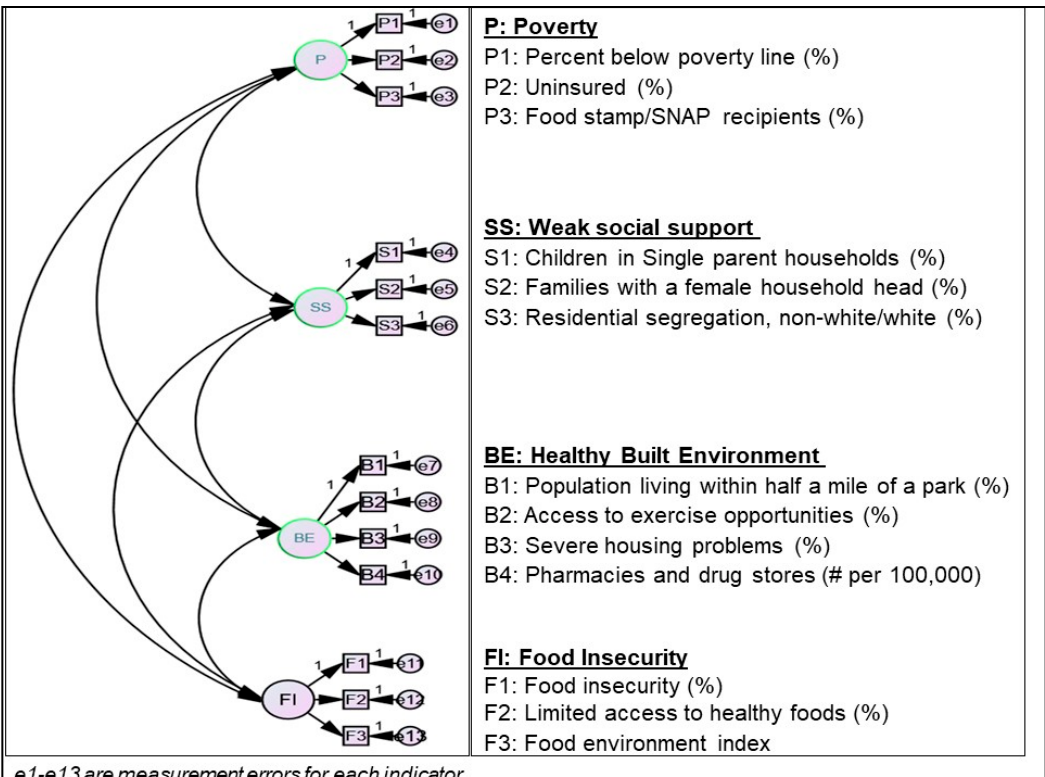
Figure 1. Hypothesized confirmatory factor analysis (CFA) model for measuring social determinants of non-adherence.